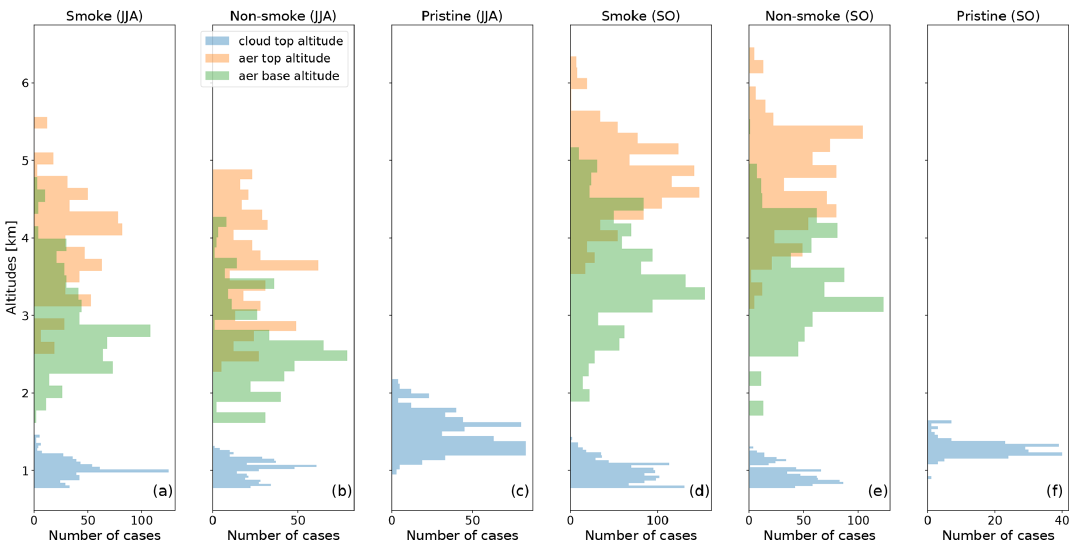
Figure 3. Altitudes of the cloud top and the aerosol (aer) top and base layers found within the area of study (latitudes from 10 to 18 ◦ S and longitudes from 2 to 10 ◦ E) during June–July–August (JJA) and September–October (SO) in the period 2007–2010. Aerosol cases are subdivided into smoke and non-smoke using the CALIOP V4 discrimination algorithm for the aerosol